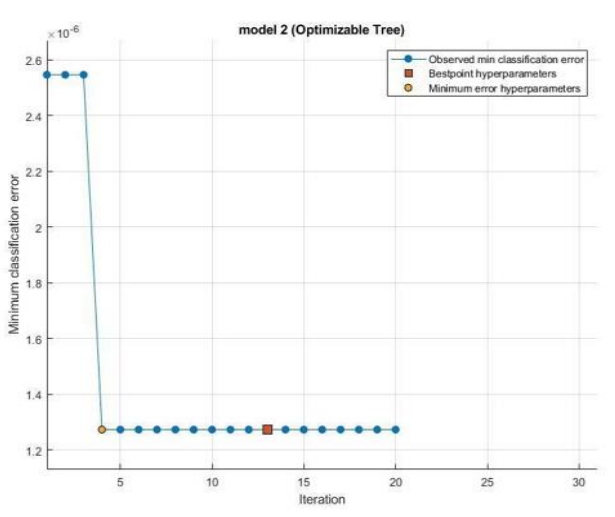
Fig. 15. OS scan minimum classification error of bayesian based optimized tree